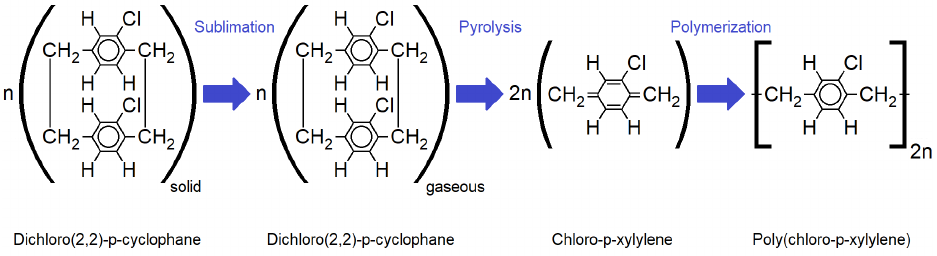
Figure 2. Molecular structure for each step of the Gorham CVD process for the deposition of Parylene C [2].